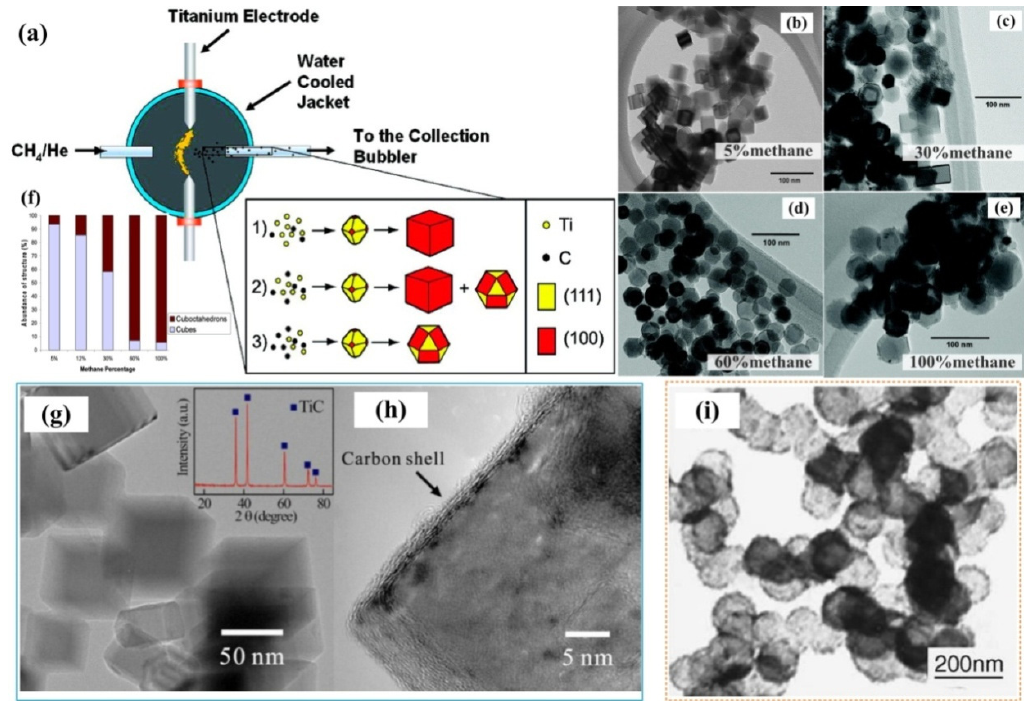
Figure 16. ( a ) Principle components of the arc discharge vessel and the various nanoparticle morphologies produced with different carbon concentrations. ( b – e ) TEM images of cube- and cuboctahedron-shaped nanoparticles synthesized with ( b ) 5%, ( c ) 30%, ( d ) 60% and ( e ) 100% methane. ( f ) Bar graph displaying the abundances of different morphologies synthesized with varying methane concentrations. It can be seen that at low methane concentrations, cubes were dominant, while at high methane concentrations, cuboctahedrons were dominant. With permission from Reference [41], copyright (2010) American Chemical Society; ( g ) TEM images of the TiC nanocubes and ( h ) the magnified detail of a cubic core-shell structure, with permission from Reference [125], copyright (2011) Elsevier; ( i ) TiC hollow spheres prepared at 400 °C. With permission from Reference [27], copyright (2004) Elsevier.